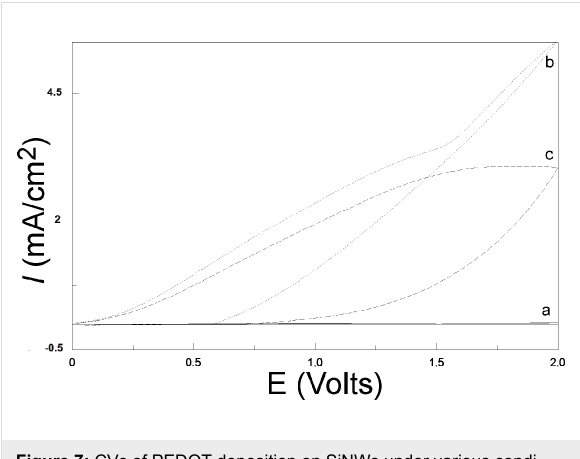
Figure 7: CVs of PEDOT deposition on SiNWs under various condi- tions. Scan rate: 100 mV/s. (a) 10 mM EDOT with 0.1 M LiClO 4 in acetonitrile solution, without illumination; (b) 10 mM EDOT with 0.1 M LiClO 4 in acetonitrile solution, under illumination; (c) 0.1 M LiClO 4 in acetonitrile solution, under